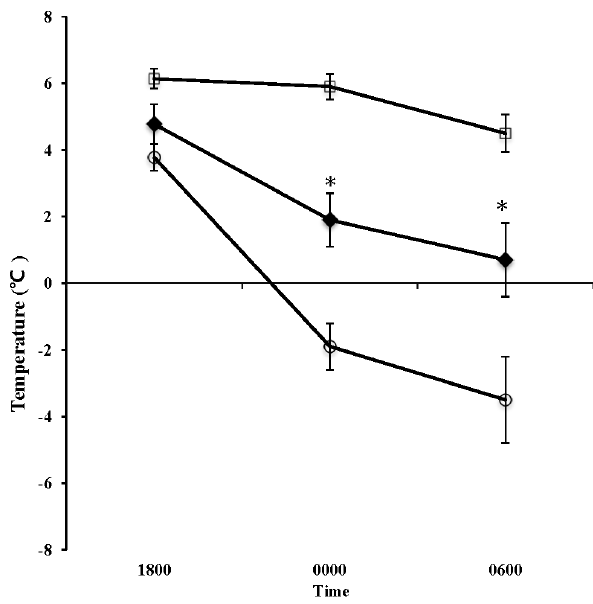
Figure 4. Changes in the dairy barn environment in unventilated (UV □ ), tunnel- ventilated barn (TV ♦ ) and the environmental temperature outside of the barn (Outside; ○ ). Values represent the mean±standard error (n = 21). * Represents statistical difference with respect to TV at p<0.05.